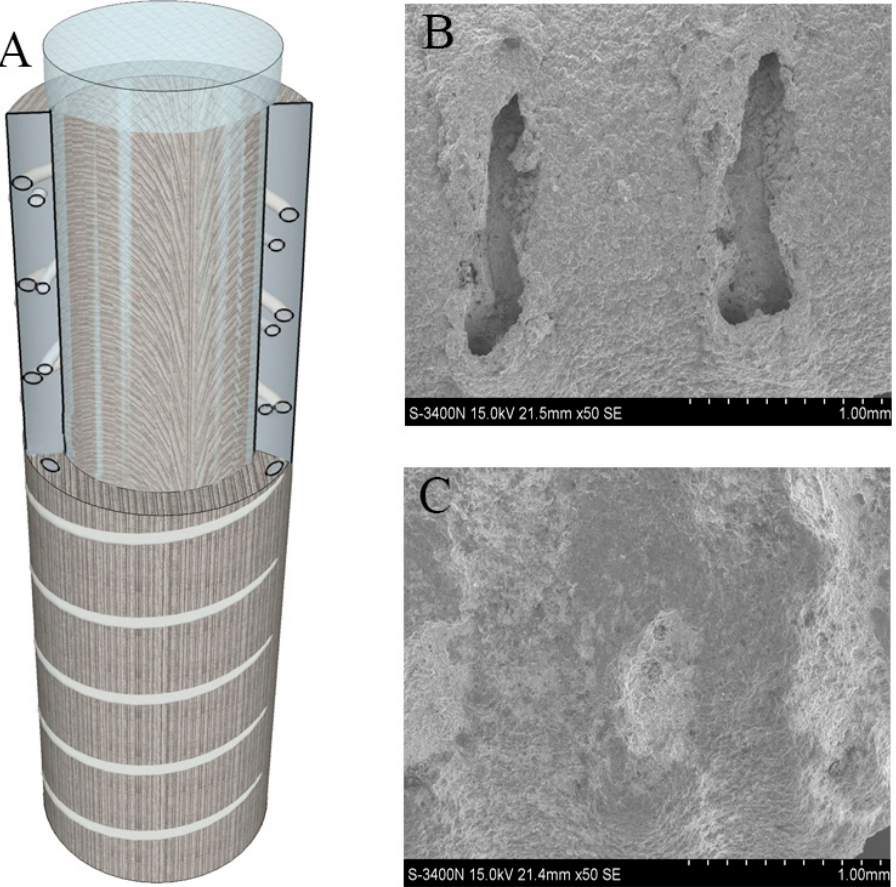
Figure 2. Ti rod surface coated with a Ti coating through a hole-structure pattern: ( A ) structure diagram; ( B ) SEM before drug loading; ( C ) SEM after drug loading. Ti coating spray (pure Ti coating), plasma spray with the placeholder filler metal etching method, and spraying preparation solution (with a through hole design Ti coating) were utilized. Vancomycin was loading through the hole pattern structures between the Ti coating